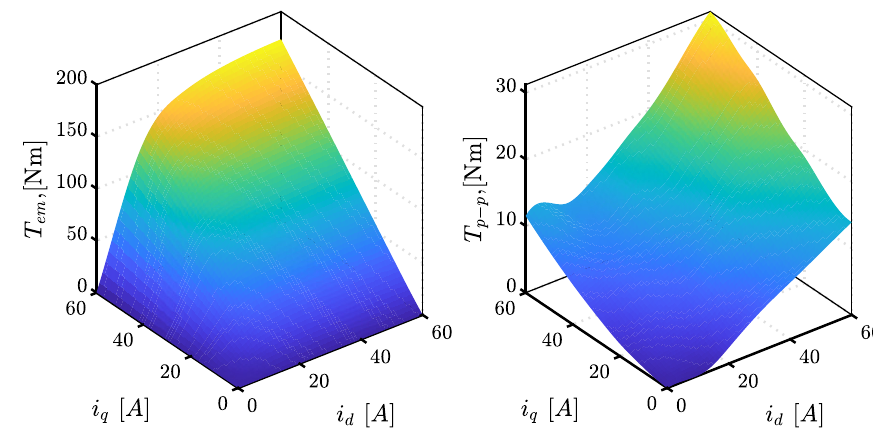
Figure 8. Average electromagnetic torque ( left ) and peak-to-peak torque ripple ( right )